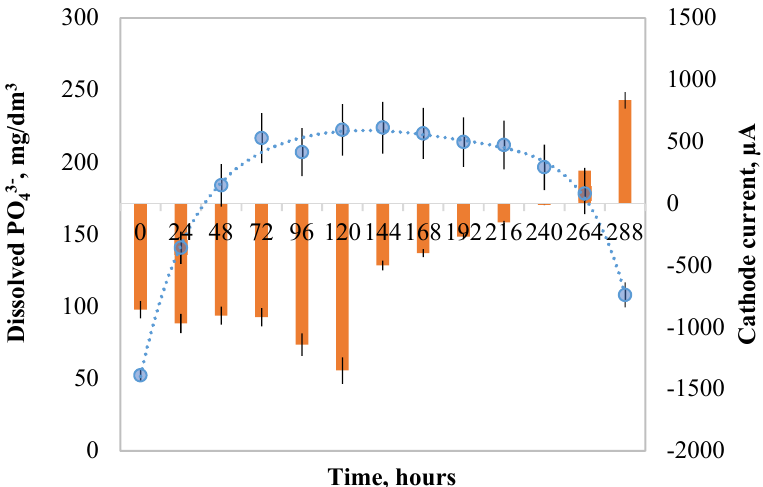
Figure 6. MFC cathode current (blue) and phosphate mobilization (orange) dynamics.